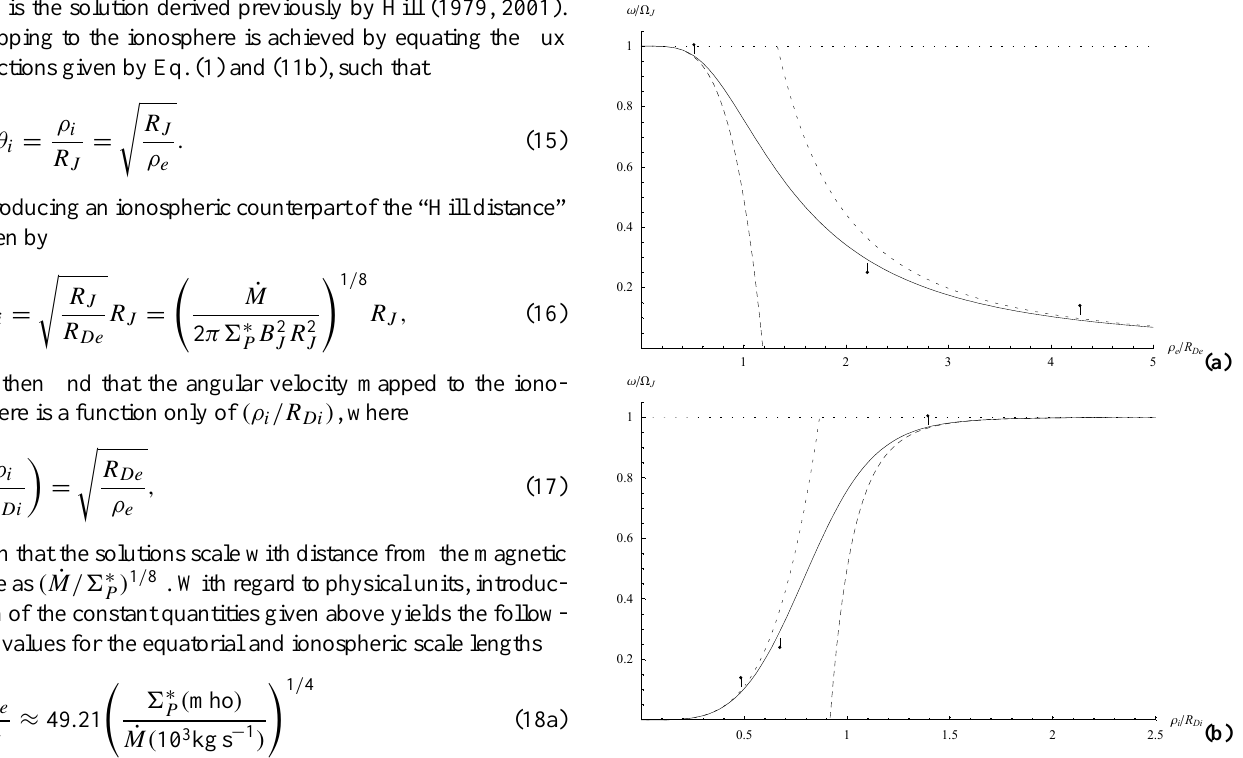
Fig. 2. Plots of the steady-state plasma angular velocity profile for a dipole magnetic field, shown (a) versus normalised radial distance in the equatorial plane (ρ e /R De ) , and (b) versus normalised dis- tance from the magnetic axis in the ionosphere (ρ i /R Di ) . The solid line in each case shows the full solution obtained from Eq. (14) with K = 0, such that the plasma rigidly corotates at small ra- dial distances. The long-dashed lines show the small ρ e form given by Eq. (19), while the corresponding large ρ e form is just (ω/(cid:127) J ) L = 0. The downward-pointing tick marks indicate the limits of validity of both these approximations, as defined in the text. The short-dashed lines show the higher-order large ρ e form given by Eq. (20), whose limit of validity (as also defined in the text) is indicated by the upward-pointing tick mark. The horizontal dot- ted lines indicate the condition for rigid corotation, (ω/(cid:127) J ) = 1.